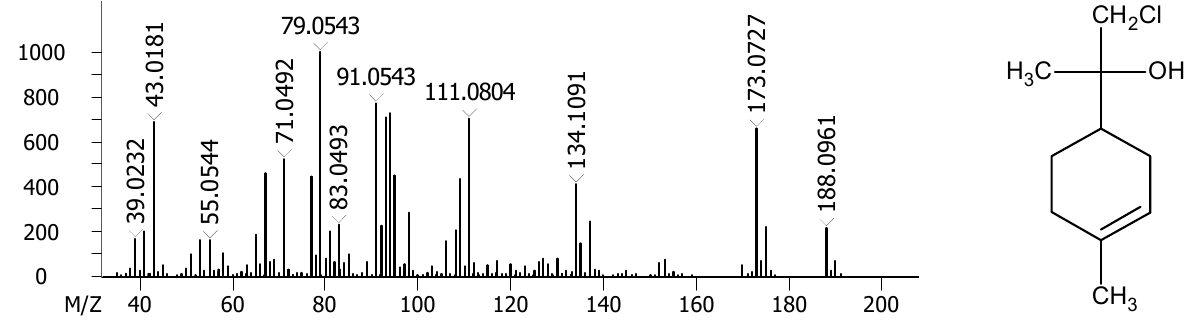
Figure 6. Mass spectrum and formula of 1-methyl-4-(1-chloro-2-hydroxyprop-2-yl)cyclohexene with RT 848s.